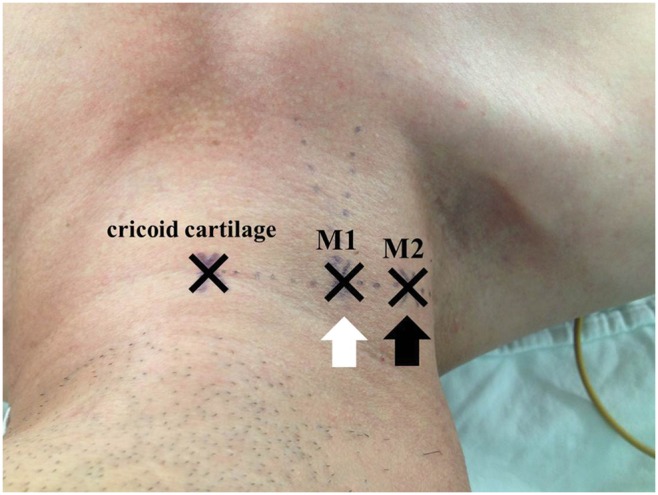
Anatomical location of the two landmarks in the patient.M1 is the central landmark (white arrow), determined by the apex of the triangle between the two heads of the sternocleidomastoid muscle. M2 is the alternative landmark (black arrow), determined by the inspection of respiratory jugular venodilation and direct internal jugular vein palpation.